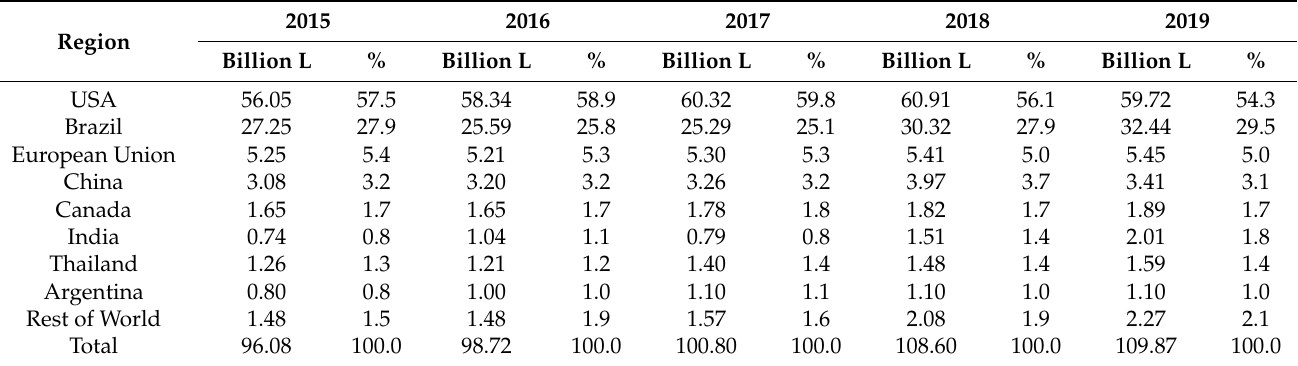
Table 1. Annual world fuel ethanol production in 2015–2019